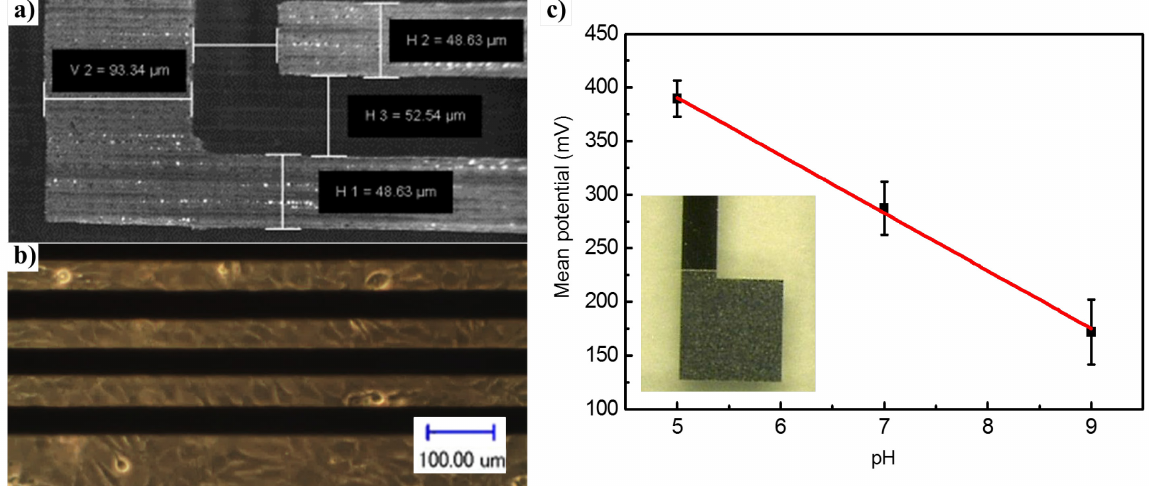
Figure 4. Images of a platinum IDES. ( a ) Scanning electron microscopy image with dimensions. ( b ) Confluent cells above the IDES. ( c ) Sensitivity test of a Si 3 N 4 sensor layer on platinum (insert: pH sensor with 1.4 × 1.4 mm 2 electrode area). The data represent measurements with six chips in pH-buffered solutions with pH values of 5, 7, and 9. The straight line corresponds to a sensitivity of − 53.8 ± 1.8